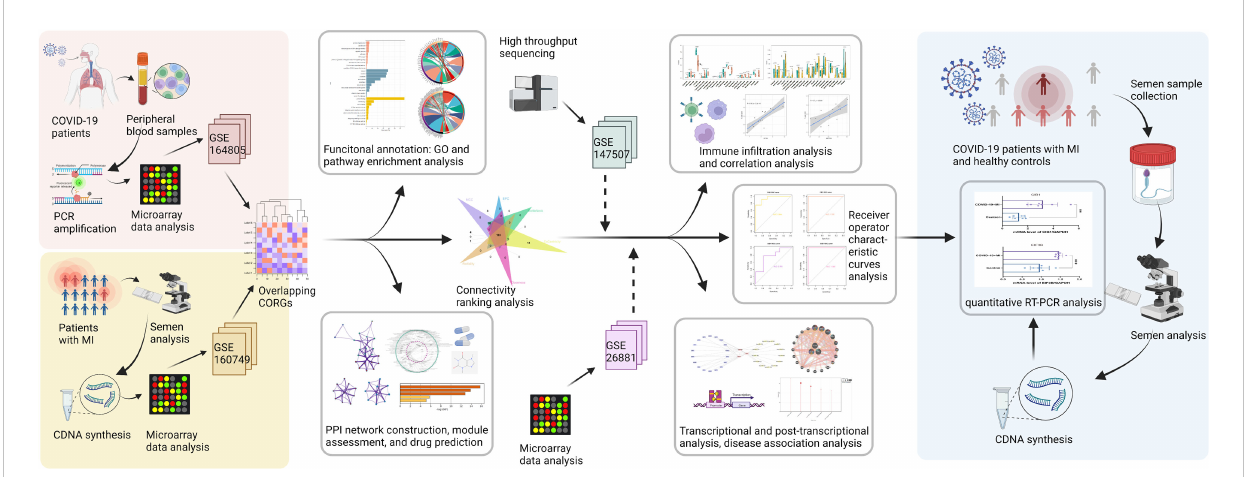
FIGURE 1 The methodical fl owchart of the study. MI, male infertility; GSE, GEO Series; CORGs, COVID-19-related differentially expressed genes; GO, Gene Ontology; PPI, protein-protein interaction; ROC, receiver operating characteristic; PCR, polymerase chain reaction; quantitative RT-PCR, quantitative real-time polymerase chain